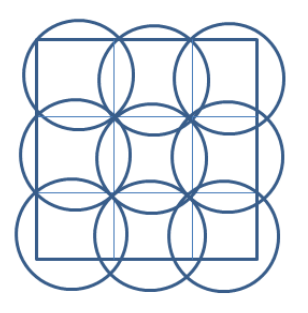
Fig. 2: Every 4 × 4 square can be covered by at most 9 unit